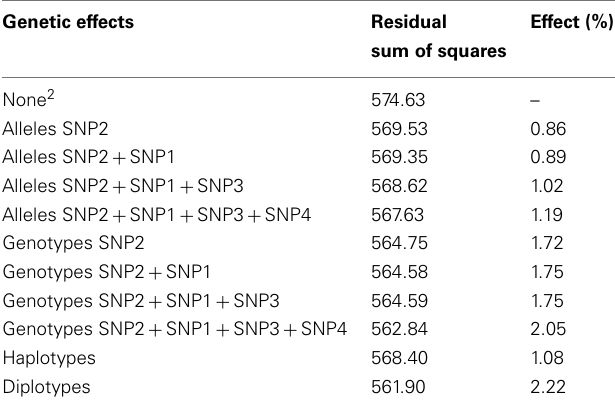
Table 3 | Size of the genetic effect for SNPs, genotypes and haplotypes of haplotype block 4 for the average milk fat yield over the first three lactations in the population of 2,275